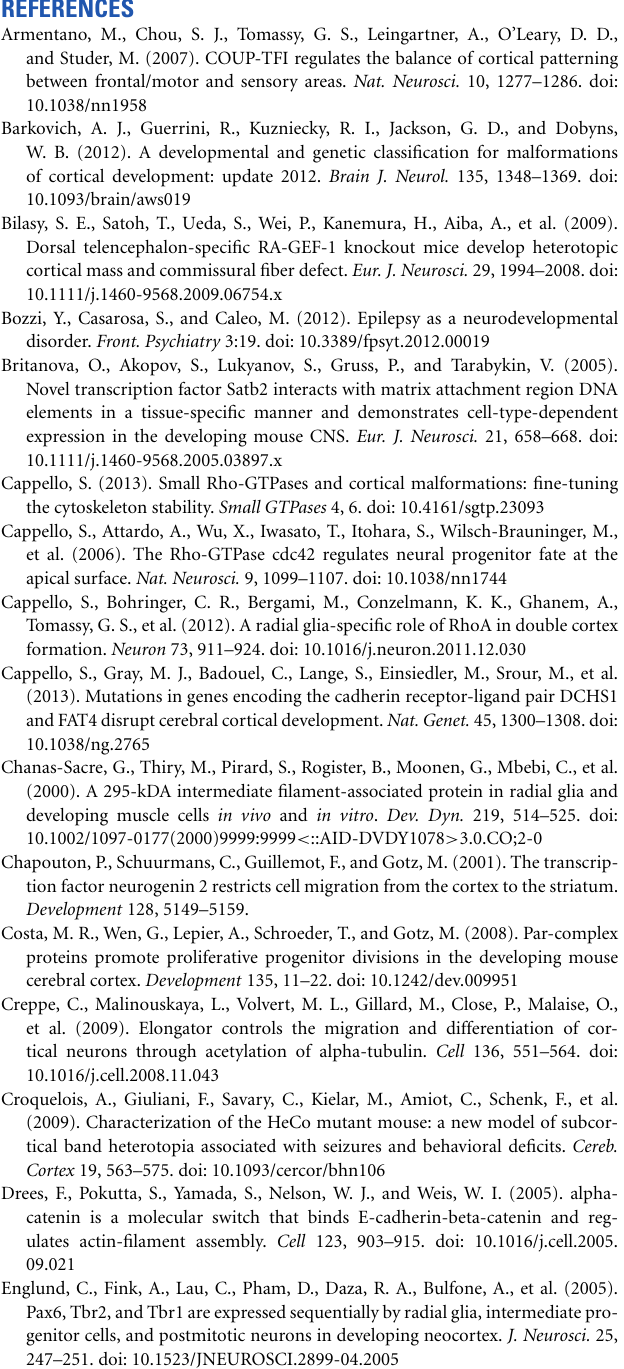
Figure S2 | Adherens Junctions upon loss of α -catenin. Electron micrographs of WT (A) and α -cat cKO (B,B (cid:2) ) E11 cortices revealing electrondense AJs (indicated by arrows). Ventricle is down in (A) . (B (cid:2) ) : high magnification of boxed area in (B) . Scale bars: 500nm. Figure S3 | Par complex upon loss of α -catenin. Western Blot of cortical tissue from E11 WT and α -cat cKO. Primary antibodies used for the comparison are indicated above the lanes, lower strips blotted for β -actin serve as loading